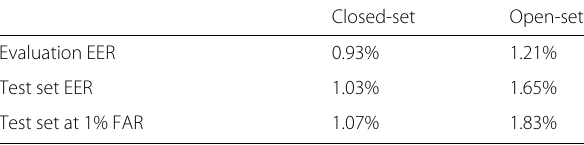
Table 2 Closed-set Lausanne protocol and open-set protocol results on the XM2VTS test set. Results are FRR at a 1% FAR